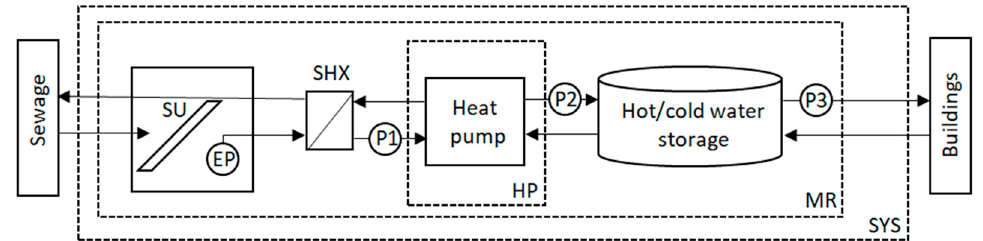
Figure 3. Hydraulic scheme and system boundaries: screening unit (SU), elevation pump (EP), sewage heat exchanger (SHX), auxiliary pumps (P1, P2), network pump (P3), heat pump boundary (HP), machinery room (MR) and overall system boundary (SYS).